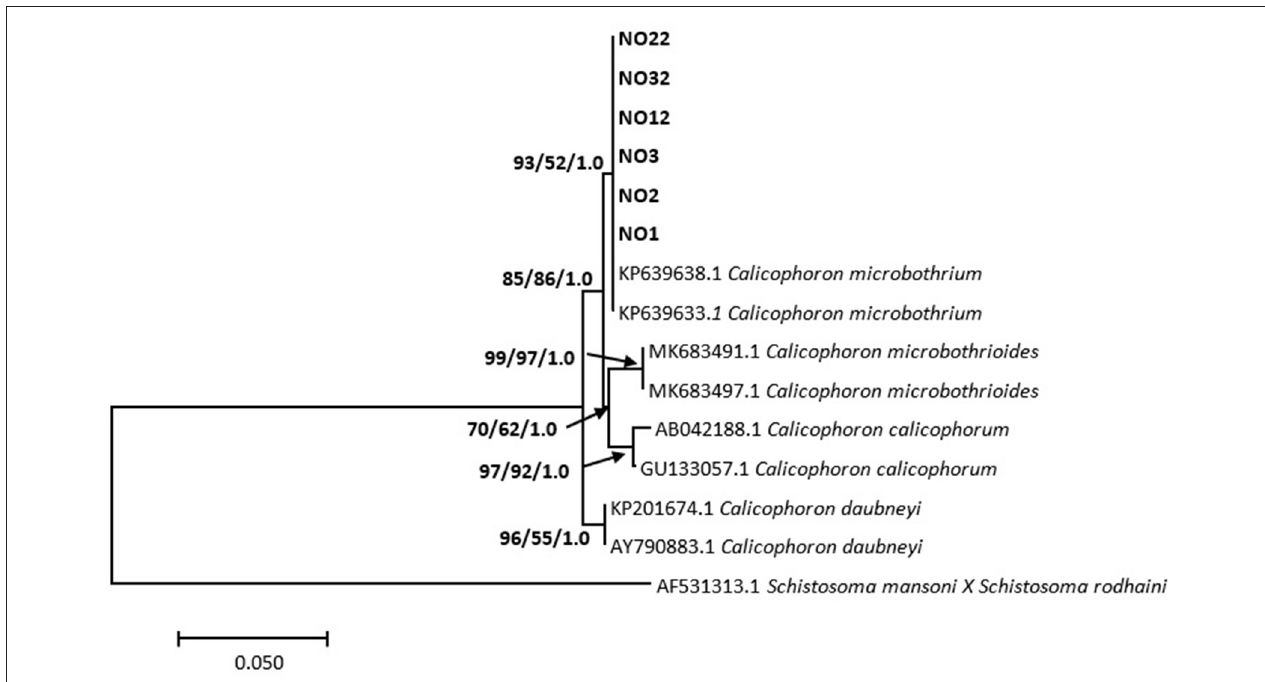
FIGURE 3 | Neighbor-joining tree based on the 373-nucleotide sequence of the ITS-1/5.8S/ITS-2 marker, confirming the identity of amphistomes from Mpumalanga province (in bold) as Calicophoron microbothrium and their relationship with Calicophoron species obtained from the NCBI GenBank database. The support value indicated on the nodes follows the order neighbor-joining bootstrap value/maximum likelihood bootstrap value/Bayesian inference posterior probability.